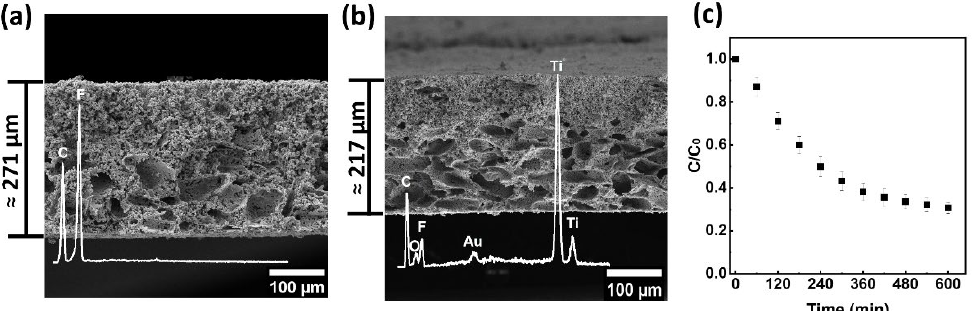
Figure 6. Cross-section SEM images of 0 wt.% ( a ) and 10 wt.% TiO 2 :Au-NSs/PVDF-HFP ( b ). Photocatalytic degradation of CIP (5 mg/L) with 10 wt.% TiO 2 :Au-NSs/PVDF-HFP membrane under 600 min of visible radiation ( c ).